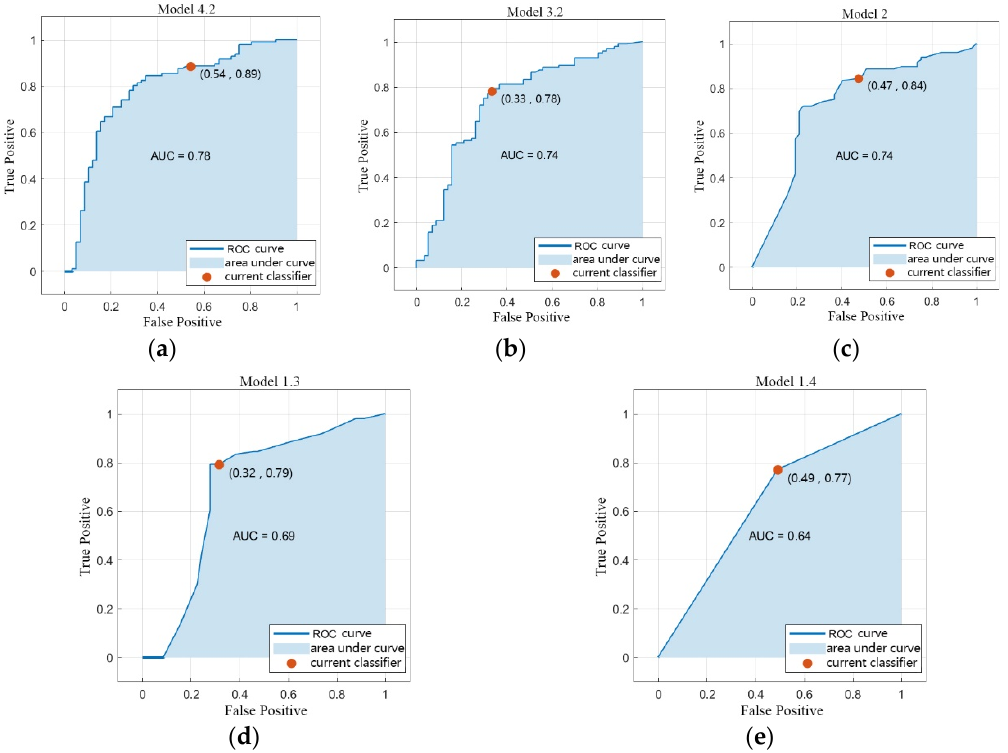
Figure 10. AUC for SVM, Naive Bayesian, Bagging, Decision Tree, KNN ( a ) SVM ( b ) Naive Bayesian ( c ) Bagging ( d ) Decision Tree ( e ) KNN.